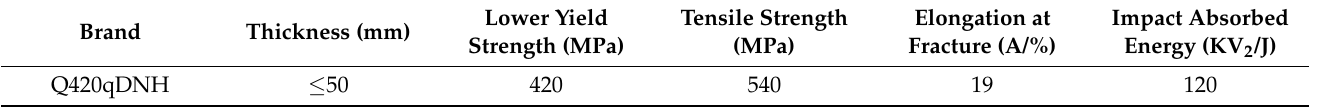
Table 2. Mechanical property parameters of bearings. Table 3. Mechanical property parameters of weathering